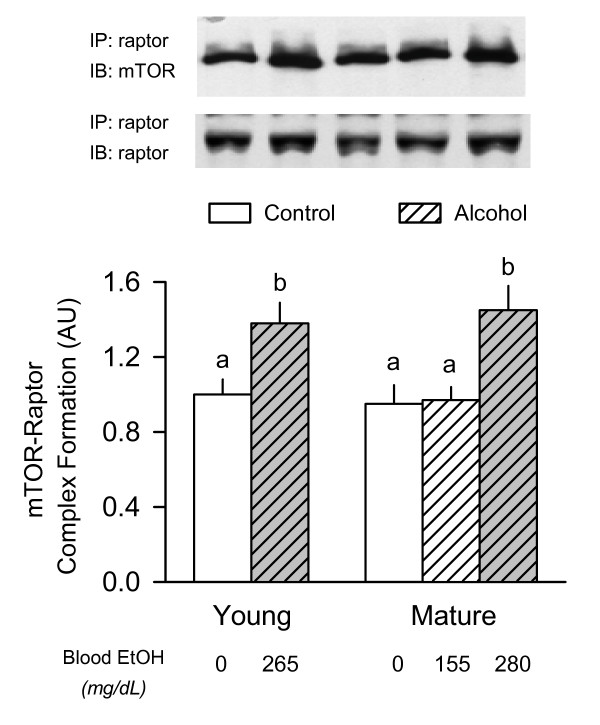
Effect of acute alcohol intoxication on the binding of mTOR with raptor in skeletal muscle from young and mature rats. Groups are the same as described in Figure 1. Gastrocnemius was collected 2.5 h after administration of alcohol or saline (control). Inset at top: raptor was immunoprecipitated (IP) and the amount of mTOR and raptor determined by immunoblotting (IB). Bottom graph: densitometric analysis of immunoblots of mTOR bound to immunoprecipitated raptor in muscle. There was no difference among the various groups for the amount of immunoprecipitated raptor (mean data not shown). Values (means ± SEM) are expressed relative to the young saline-treated control group. Sample size was 10, 10, 6, 7, 9, and 9 for the six groups, respectively. Values with different letters are significantly different from each other, P < 0.05. Values which share a common letter are not statistically different.